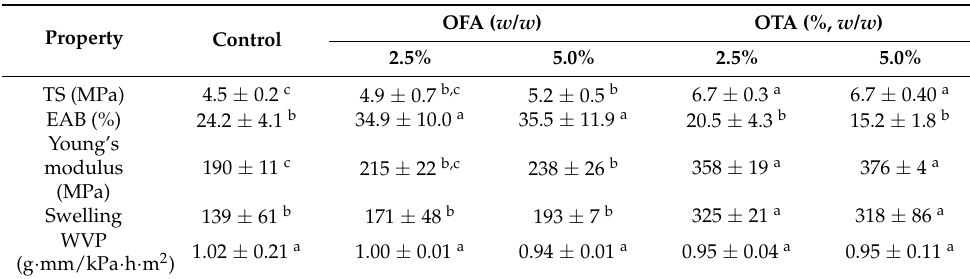
Table 2. Mechanical and selective physical properties of oxidized ferulic (OFA) and tannic (OTA) acid-treated WPI